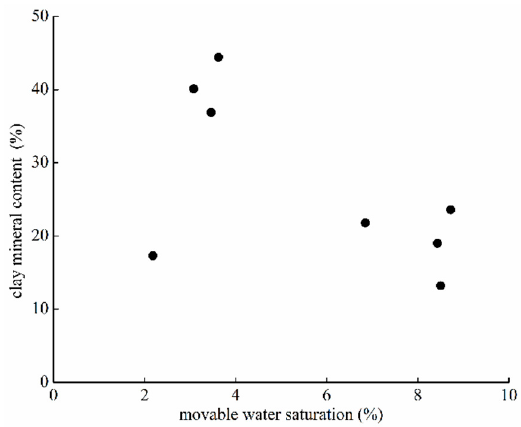
Figure 8. Clay mineral content versus movable water saturation.